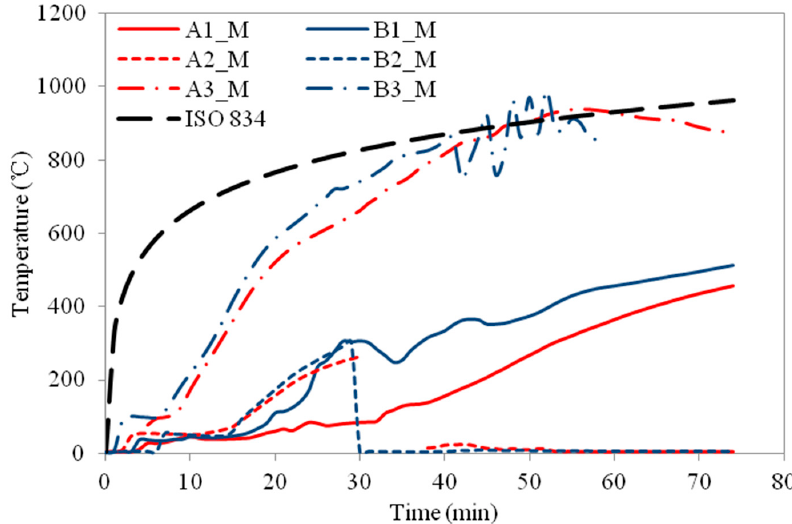
Figure 9. Temperature profiles at the medium section for HSS-C1. Materials 2018 , 11 , x FOR PEER REVIEW